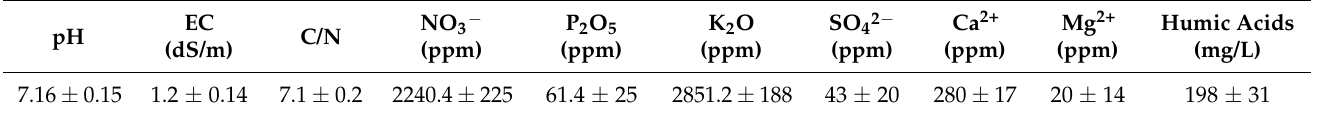
Table 1. Chemical characteristics of the studied CT. Results are indicated as mean ± standard devi- ation.